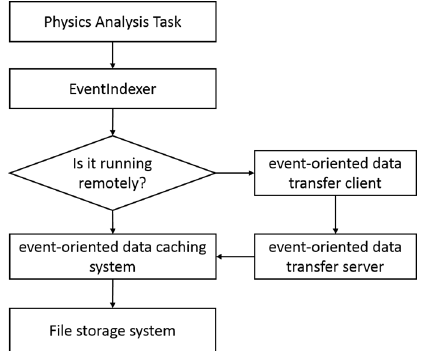
Fig. 6. The workflow of event-based data